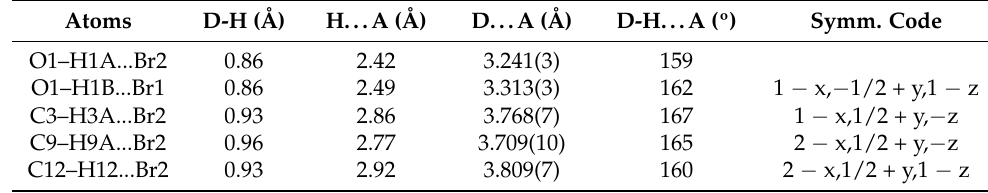
Table 3. Hydrogen bond parameters in the [Co(L)(H 2 O) 2 Br]Br complex.